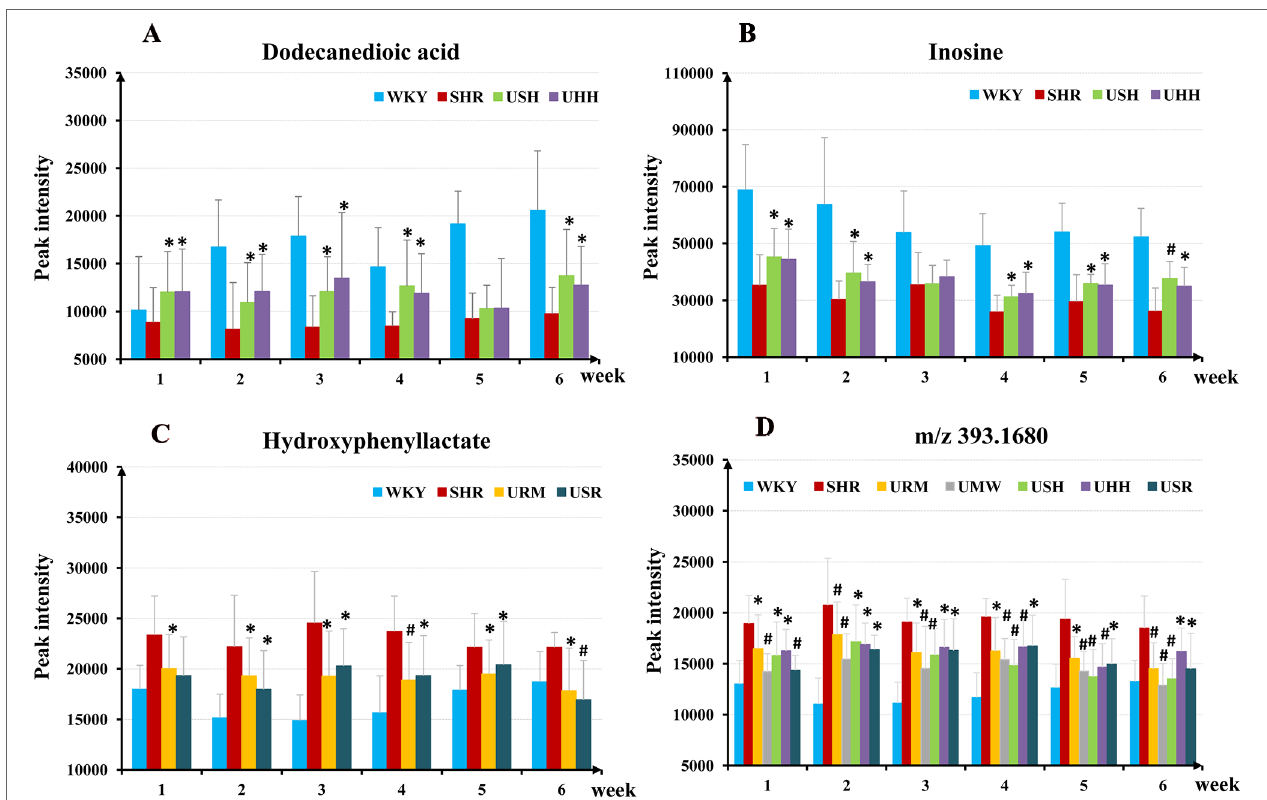
FIGURE 6 | The relative abundances of the dodecanedioic acid (A) , inosine (B) , hydroxyphenyllactate (C) , and the potential hypertension biomarker ( m / z 393.1680) (D) in the WKY group, the SHR group, and the different treatment groups within the 6-week intervention period. * p < 0.05, # p < 0.01 compared to the SHR